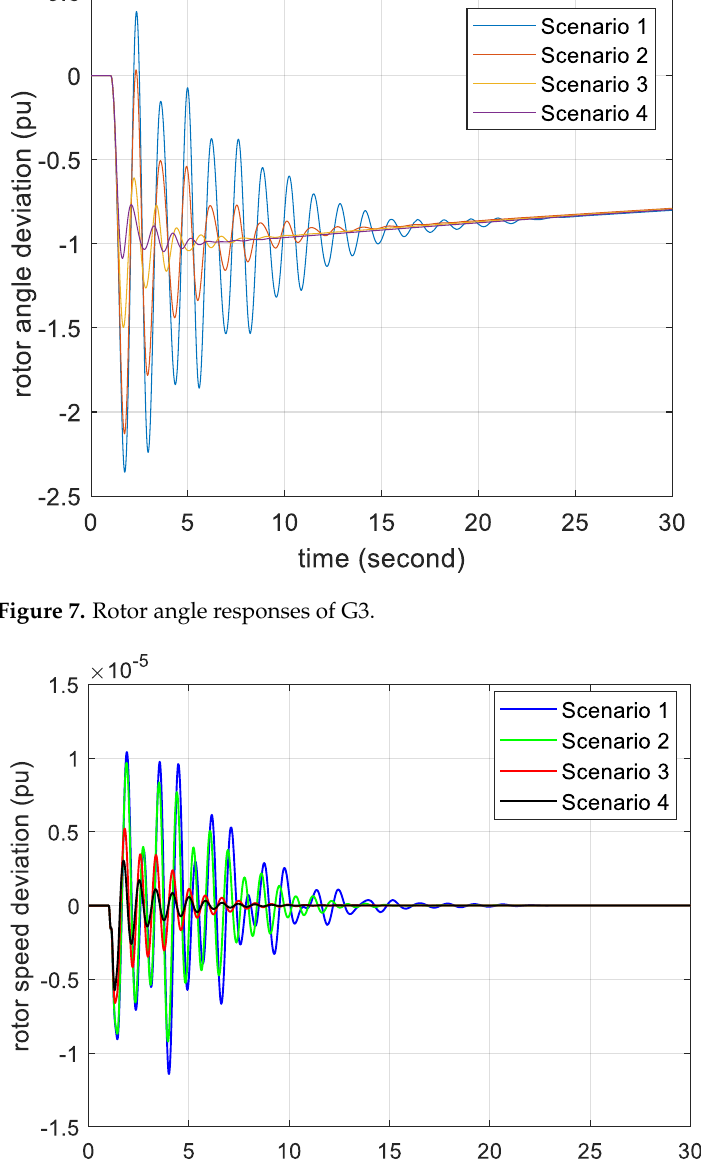
Figure 8. Rotor speed responses of G4.